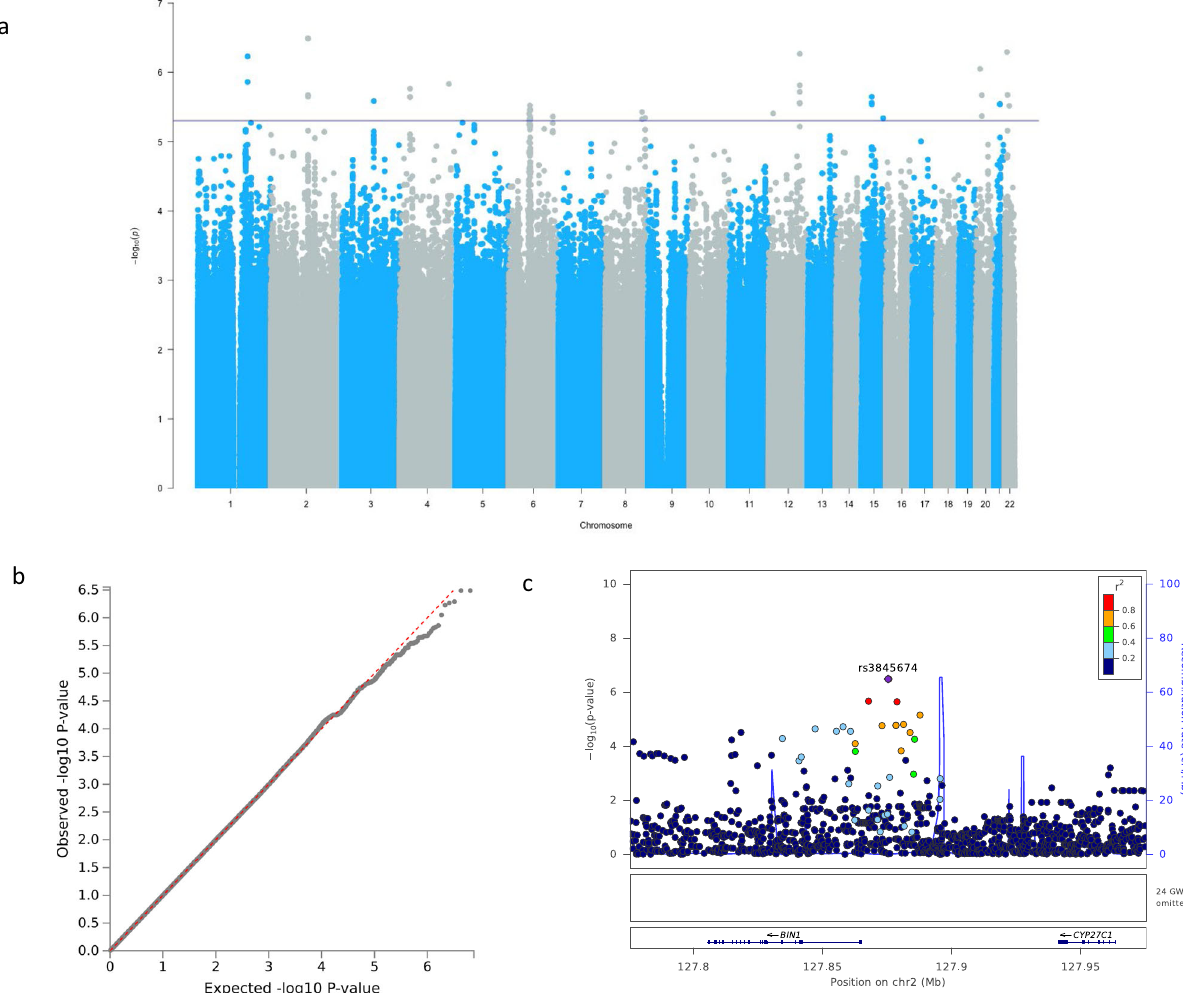
Fig. 3 Genome-wide and suggestive associations with executive function. a Manhattan plot. No genome-wide or near genome-wide signi fi cant signals. Suggestive cut-off 5 × 10 − 6 shown by a blue line. b QQ-plot ( λ = 1.00) for association summary statistics. c Locus zoom plot for rs3845674. LD values are based on a South African LD